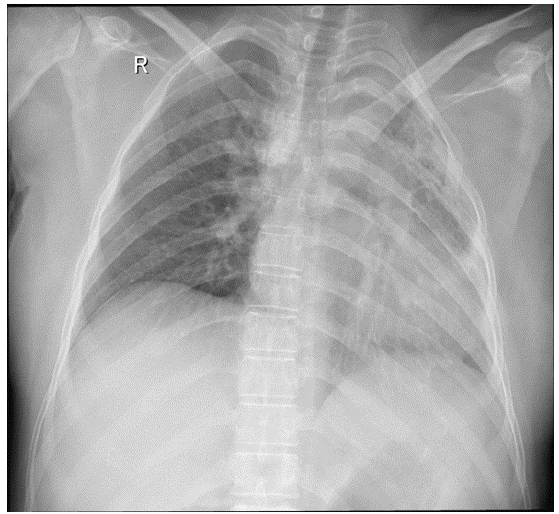
Figure 1. Chest radiograph: left pulmonary opacities, fibrosis, and bronchiectasis. Dense consolida- tion in the left upper lobe with clear evidence of volume loss.